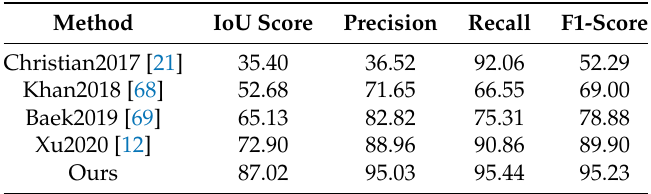
Table 7. Hand detection results on RHD hand